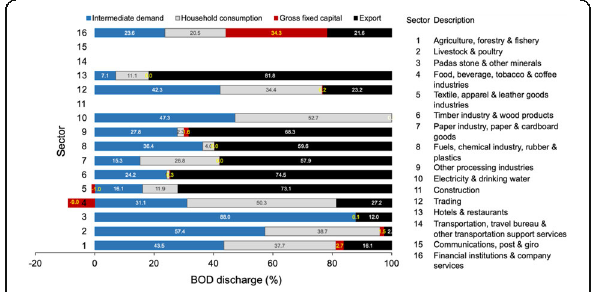
Fig. 4 Percentage of total BOD discharge attributable to each component of each sector ’ s total output Note: Sectors 11, 14 and 15 do not release significant